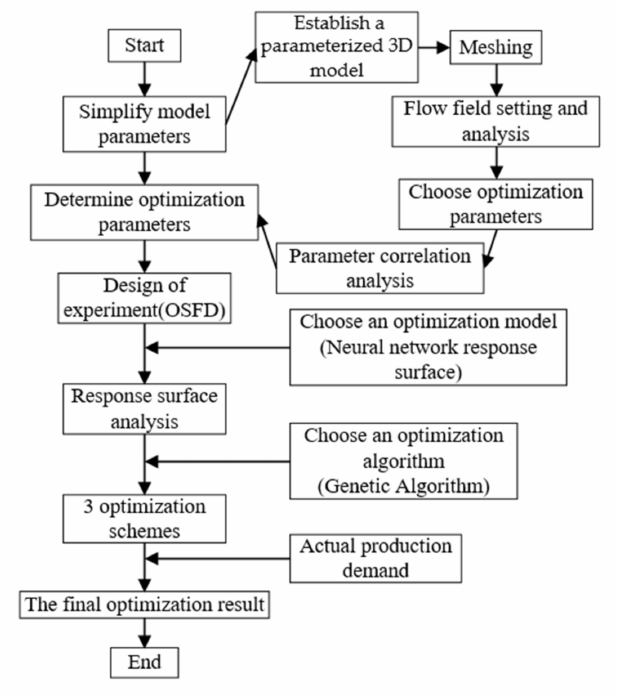
Figure 6. Structure optimization